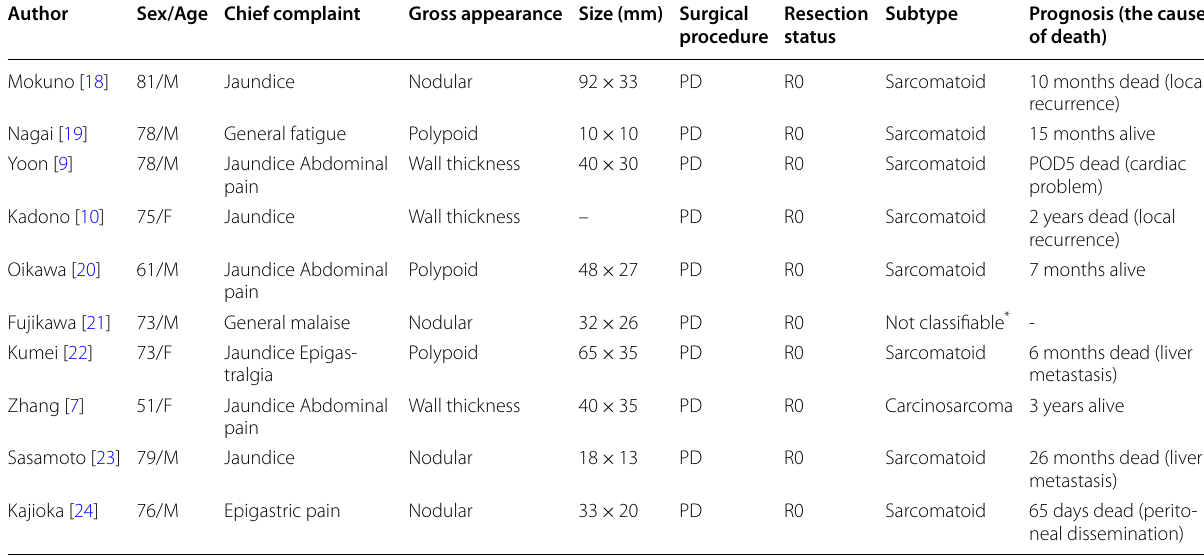
PD pancreatoduodenectomy *The tumor cells resembled neuroendocrine or small cell carcinoma